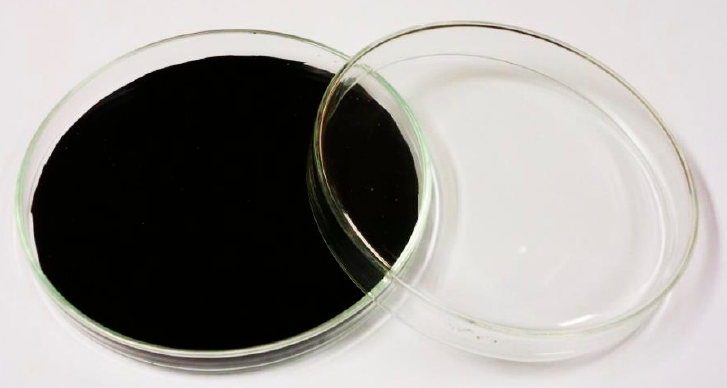
Figure 2. Ethylene propylene diene monomer (EPDM)-based nanocomposite in an abrasion cell that consists of two glass Petri dishes.